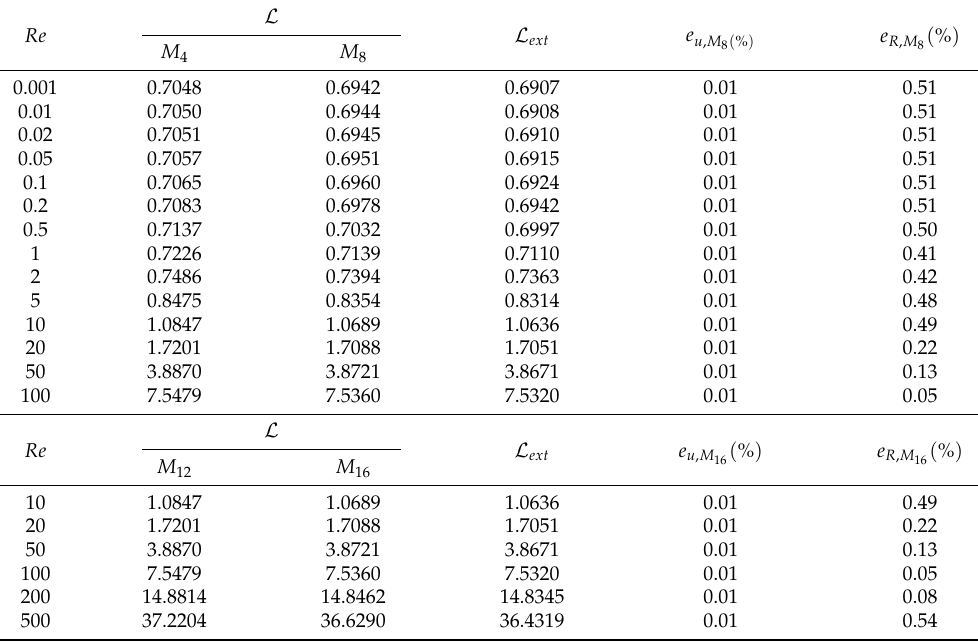
Table A4. Mesh accuracy tests and development lengths for AR =